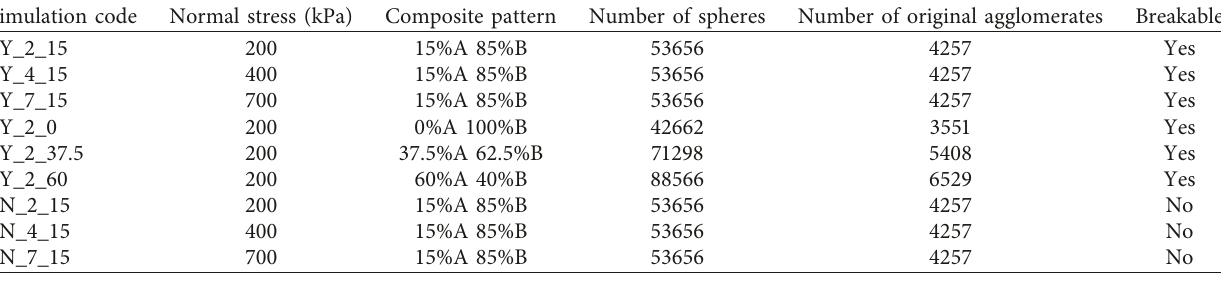
Table 1: Summary of numerical DEM